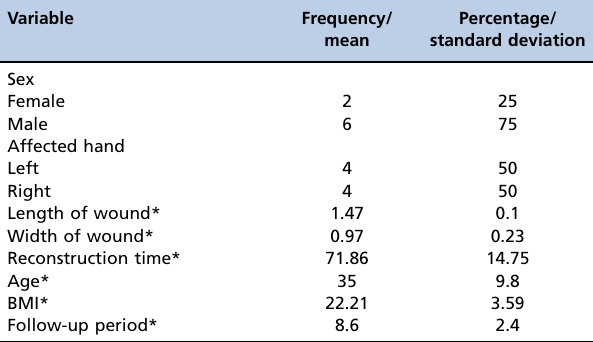
Table 1 - Demographic characteristics of the patients.